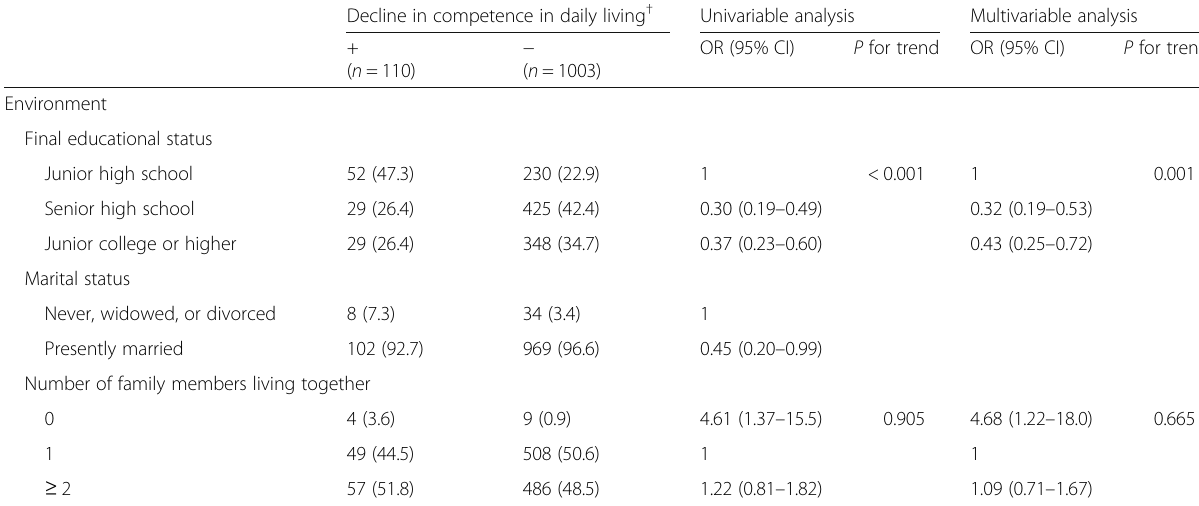
Table 2 Association of lifestyle/psychosocial factors at age 64 years with reduced competence in daily living at age 70 years (males)